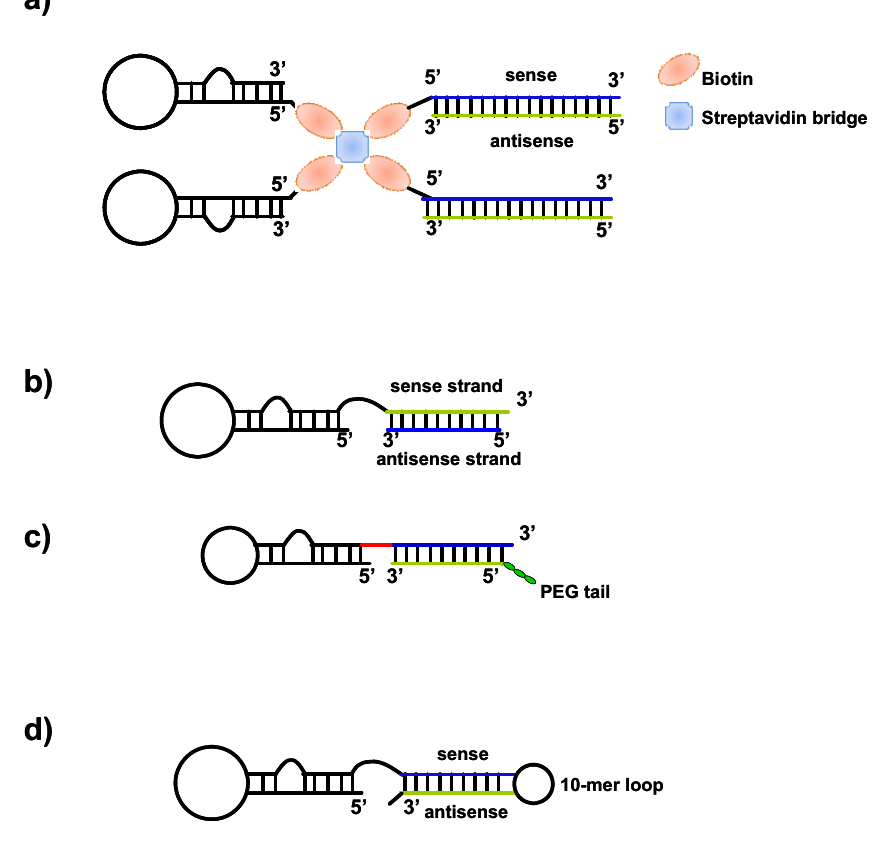
Figure 2. Anti-PSMA aptamer-siRNA chimeras. ( a ) The RNA duplex and RNA aptamers are chemically conjugated with biotin. Thus, two biotinylated siRNAs and two aptamers are non-covalently assembled via streptavidin; ( b ) The 3 ′ end of the aptamer is extended to contain the nucleotide sequence that is complementary to the antisense strand of the siRNA, and the chimera is formed by annealing the aptamer to the siRNA antisense strand; ( c ) optimized chimeras in which the aptamer portion of the chimera is truncated, and the sense and antisense strands of the siRNA portion are swapped. A two-nucleotide 3 ′ -overhang and a PEG tail are added to the chimera; ( d ) the 3 ′ -terminus of the aptamer is conjugated to the sense strand of the siRNA, followed by a 10-mer loop sequence and then by the antisense strand of the